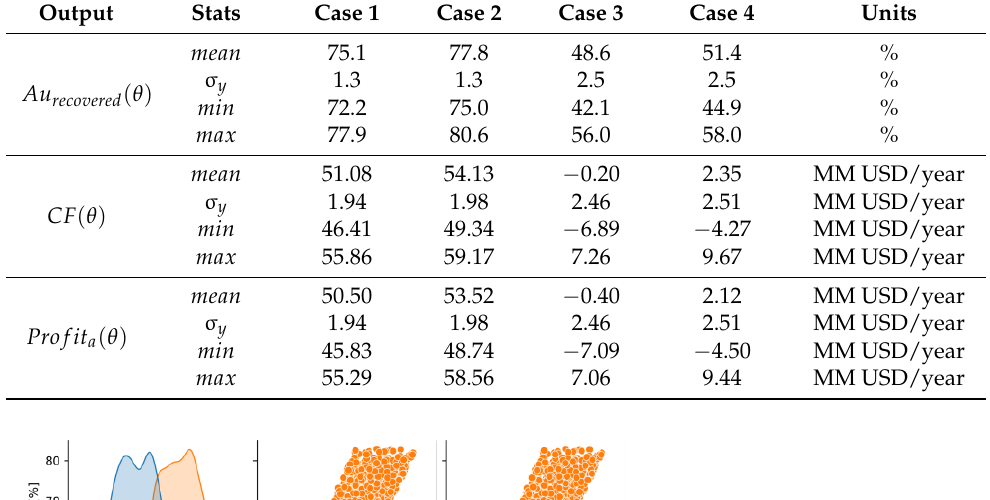
Table 8. Summary statistic (mean or expected value, standard deviation, and minimum and maxi- mum values) of the four hydrometallurgy alternatives studied.